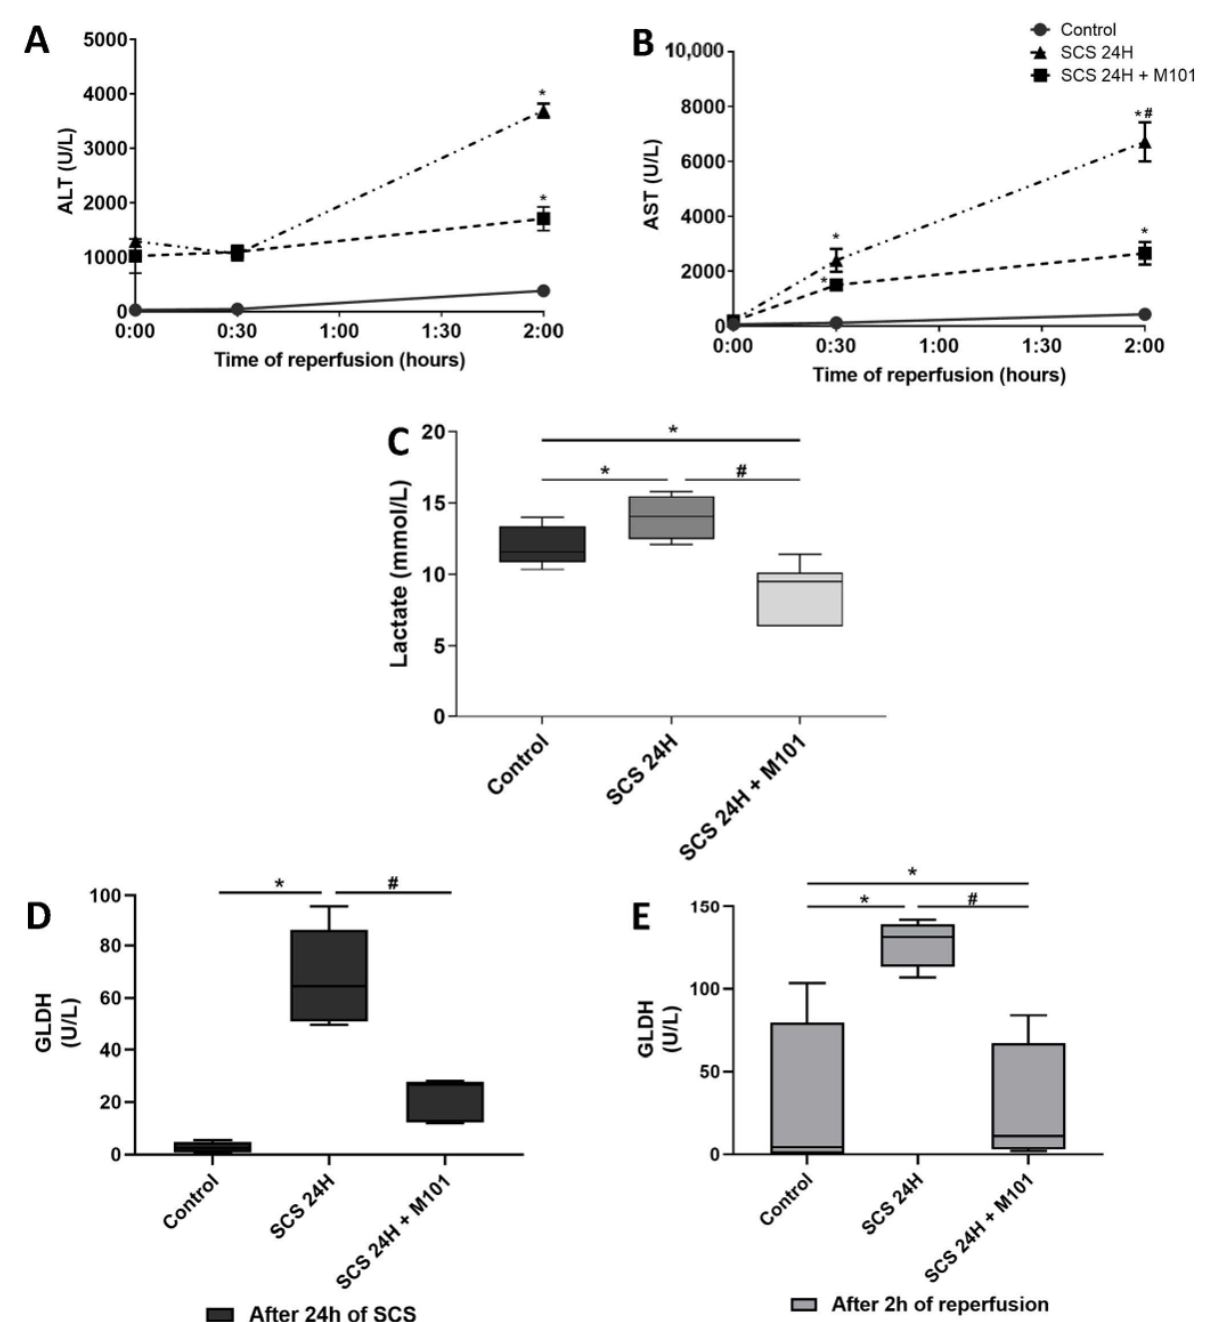
Figure 1. Hepatocellular and mitochondrial injury. ( A ) Aminotransferase (ALT) and ( B ) aspartate aminotransferase (AST) release remained lower in the control group than in both other groups during the 2 h of reperfusion. At the end of the reperfusion, transaminases release in the SCS-24H + M101 group was decreased as compared with SCS-24H group. Data are represented as mean (SEM). ( C ) Lactate levels were significantly lower in the SCS-24H + M101 group than in the control and SCS-24H groups after 2 h of reperfusion. The control group lactate levels were decreased, as compared with the SCS-24H group. ( D , E ) Glutamate dehydrogenase (GLDH) expression after 24 h of SCS was higher in the SCS-24H group. Following the 2 h of reperfusion, the level of GLDH in the SCS-24H group remained significantly the highest. Data are represented as mean (SD). n = 12/group, * = p < 0.05 vs. control and # = p < 0.05 vs. SCS-24H